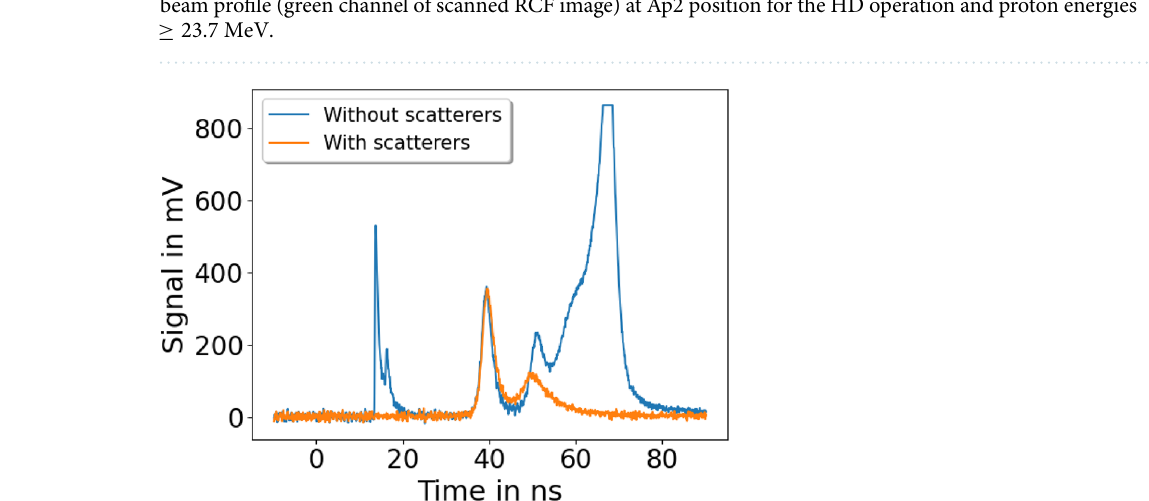
75 ps originates from the rise ± 22.2 MeV . f 3 ) The proton ≥